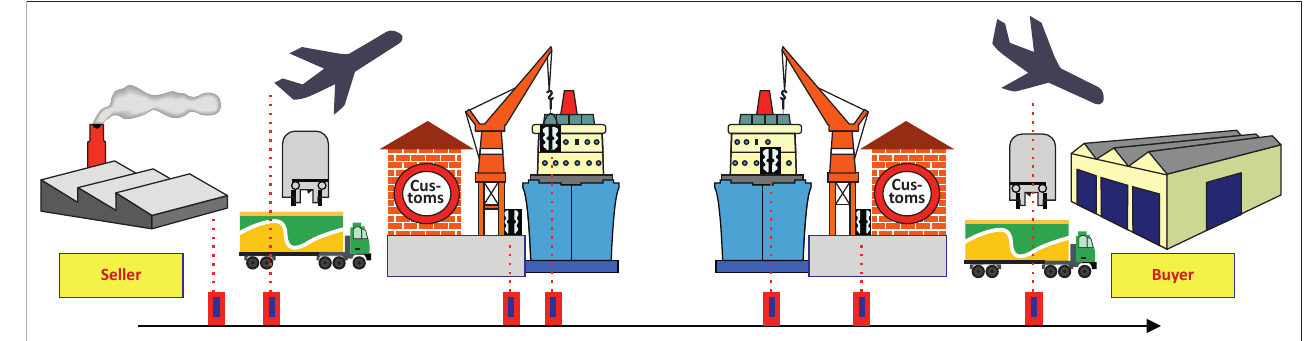
FIGURE 1: Global trade value